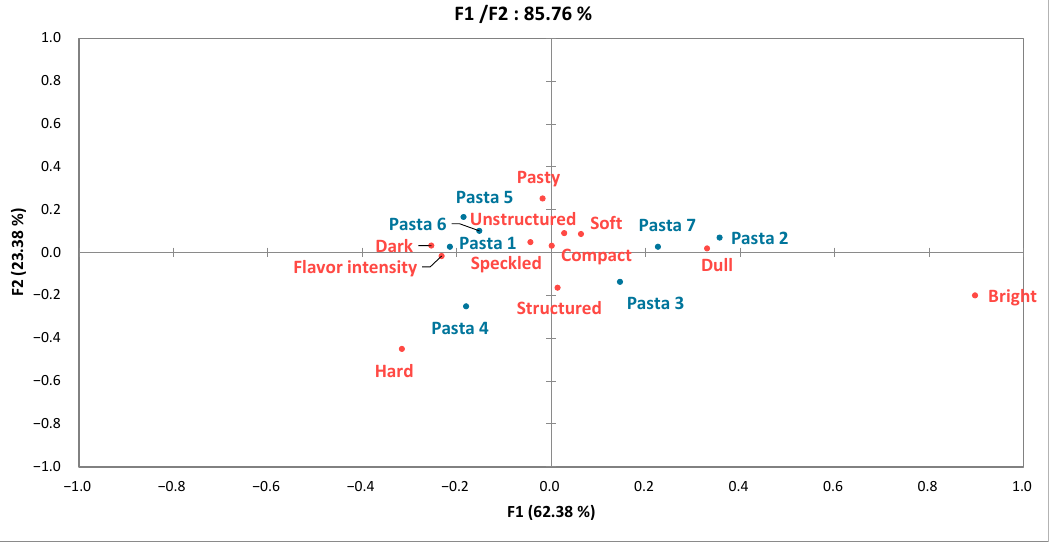
Figure 4. Correspondence analysis of the contingency table obtained from the Pivot analysis .